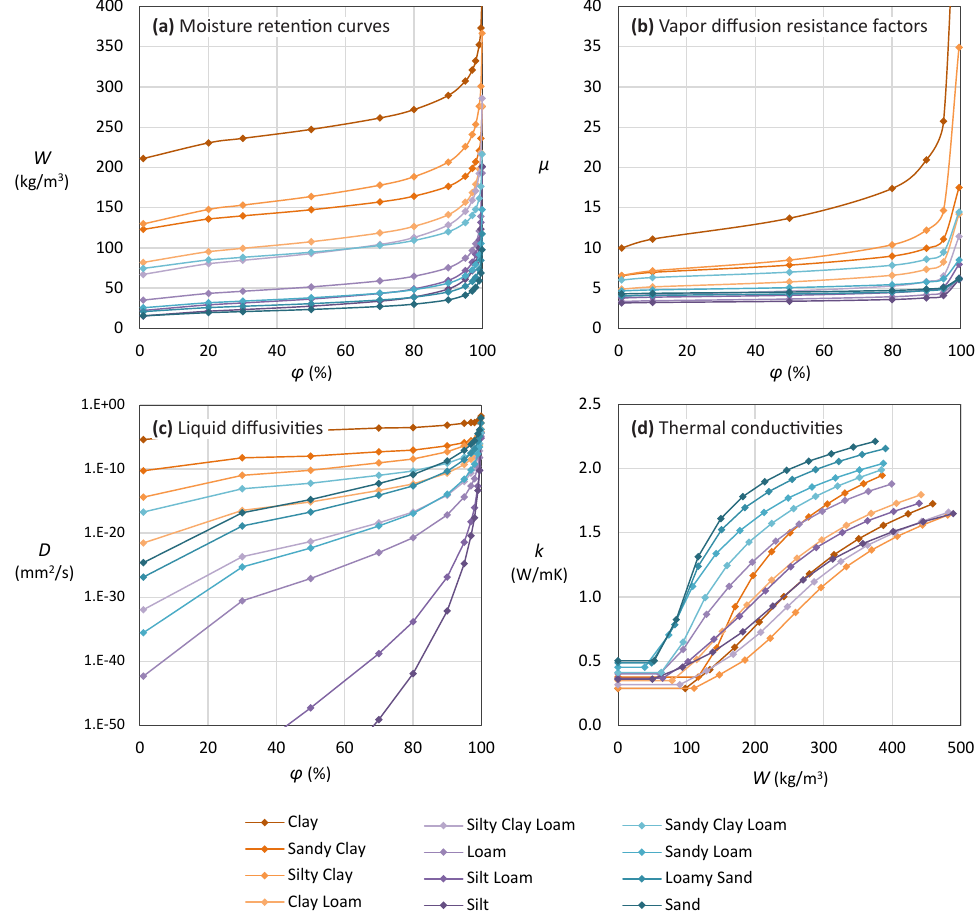
Figure 3. Soil properties used in estimating intrinsic evaporative cooling behavior: ( a ) moisture retention curves W ; ( b ) vapor diffusion resistance factors µ ; ( c ) liquid transport coefficients D ; and ( d ) moisture-dependent thermal conductivities k , grouped by color to reflect clay-like (red-orange), silt-like (purple), and sand-like (turquoise) soils. Sand and clay contents for each textural class follow [43] (Figure 2), with W obtained from Equation (6), µ from Equation (8) using n from [43], Equation (9) used in calculating D , and k from